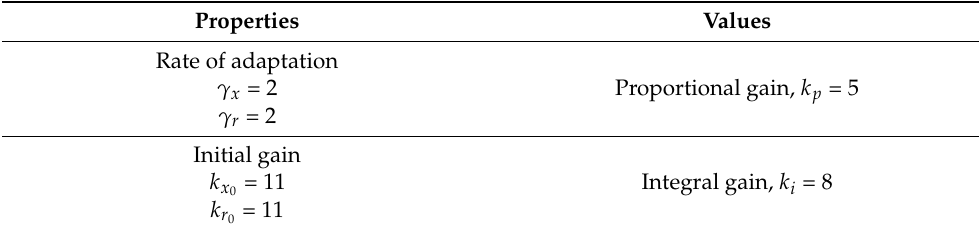
Table 2. Parameters of DMRAC and PI controller.